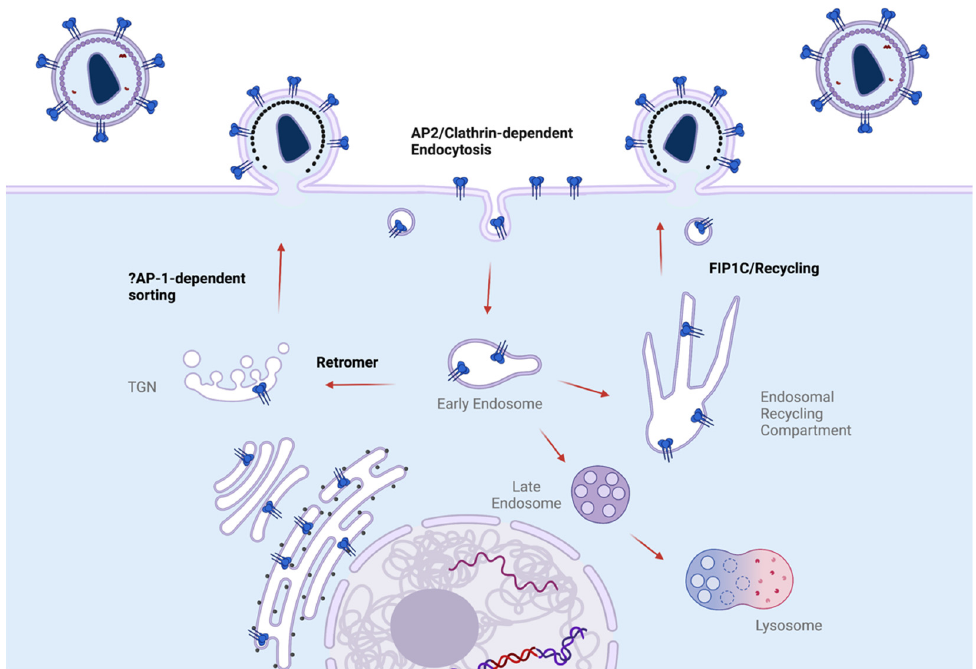
Figure 4. Schematic of pathways available for Env trafficking from the early endosome. Env may follow a pathway to degradation through early-to-late endosomes, which fuse with the lysosome. Two potentially productive pathways for Env trafficking back to the surface are shown. The endoso- mal recycling compartment has been shown to play a role in Env incorporation, mediating recycling to the PM. The retromer complex directs Env to the TGN, where AP-1-dependent sorting may play a role in particle incorporation of